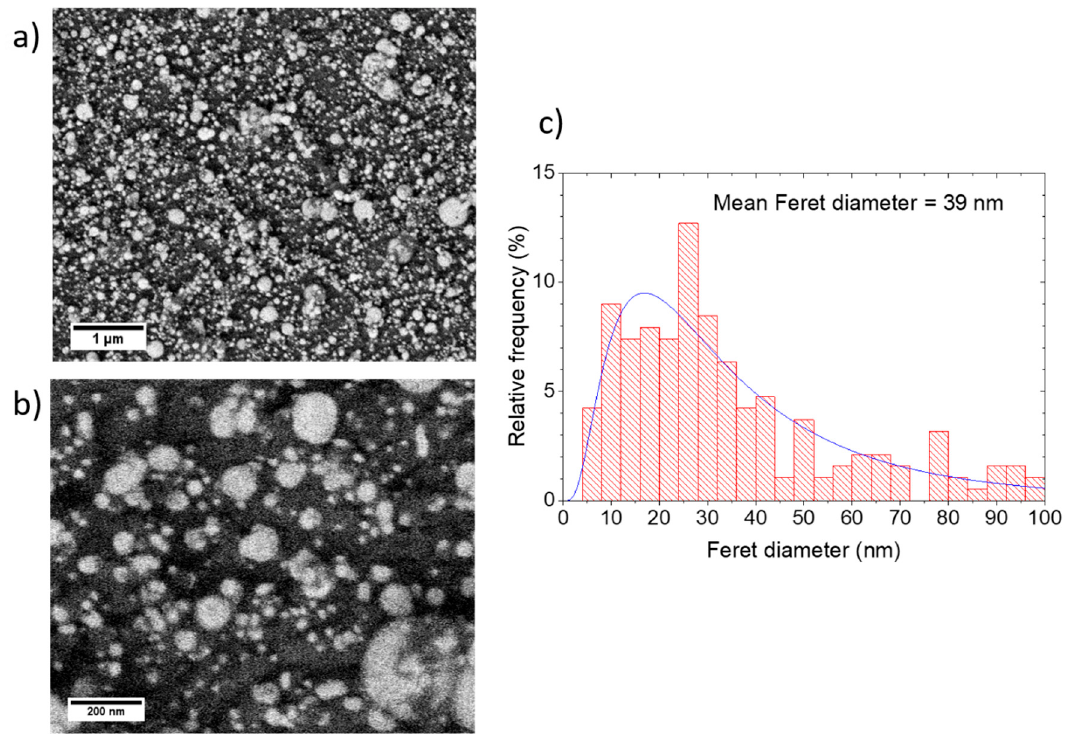
Figure 7. SEM images of a film made at 1 mm target-substrate separation, 25 μ m laser spot spacing ( a , b ), and the corresponding Feret diameter distribution ( c ).